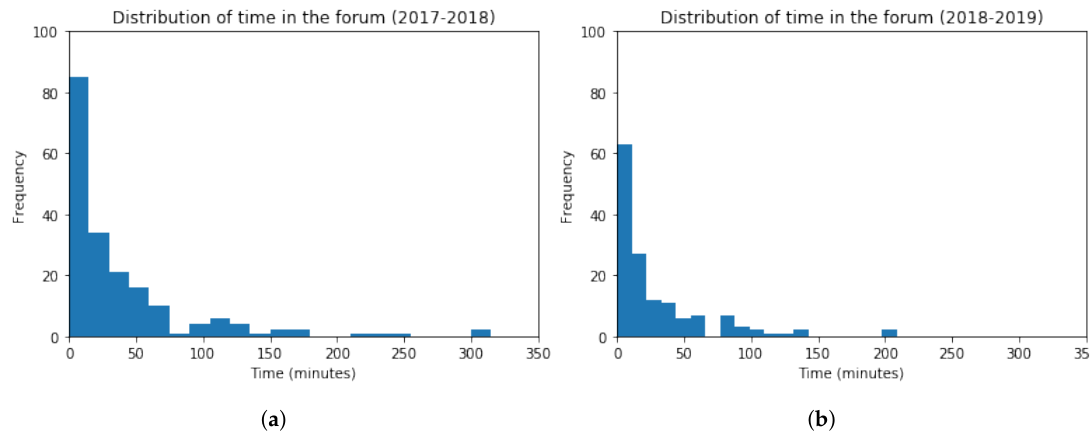
Figure 16. Histogram Graphs for the Time spent in the Forum. ( a ) 2017–2018 ( b )